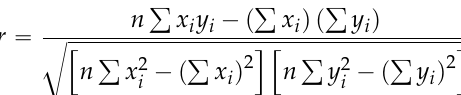
Figure 5. Monthly mean values of PM 2.5 . Colored lines represent days from Monday to Sunday.